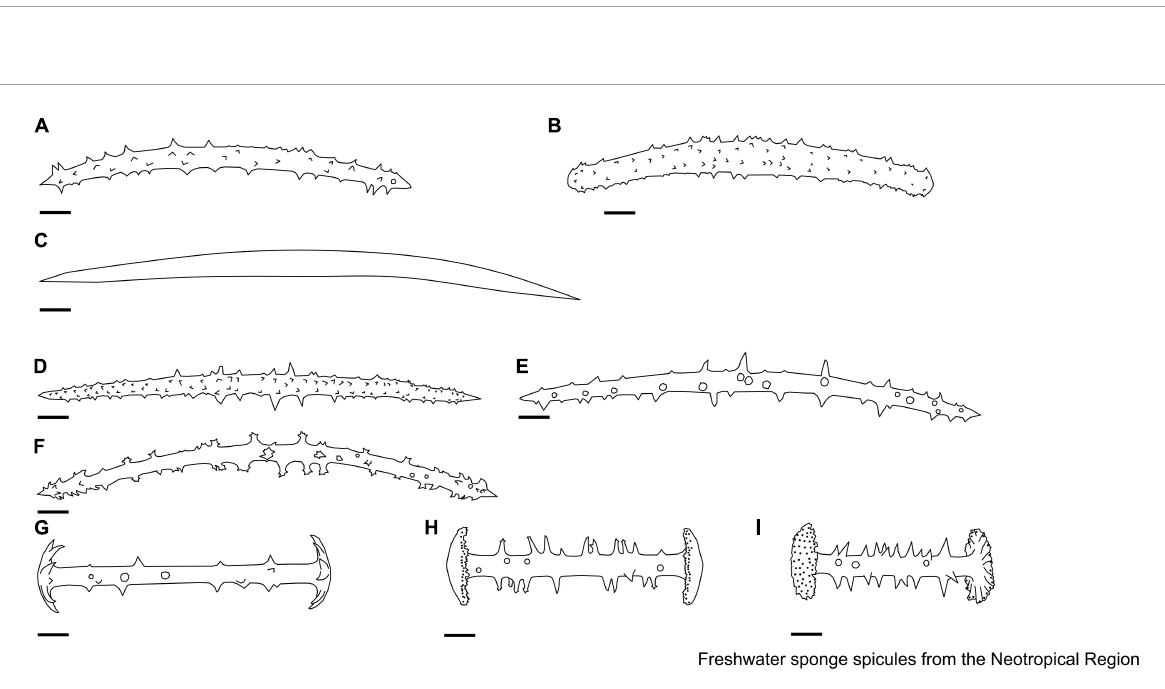
FIGURE5 (A–C) Eunapius Gray, 1867. Gemmuloscleres. (A) Acanthoxea; (B) acanthostrongyles; (C) oxea. (D–I) Heteromeyenia Potts, 1881. Microscleres. (D–F) Acanthoxeas, spines can be straight or curved, simple or compound (have a bouquet-like structure); gemmuloscleres. (G) Pseudobirotules; (H) birotules, shafts with conical spines (simple or compound). Rotules are smooth with microspines on their margins; (I) birotules with the spined shaft. Rotules are entirely covered in microspines, with serrate margins. Scale: 10 µ